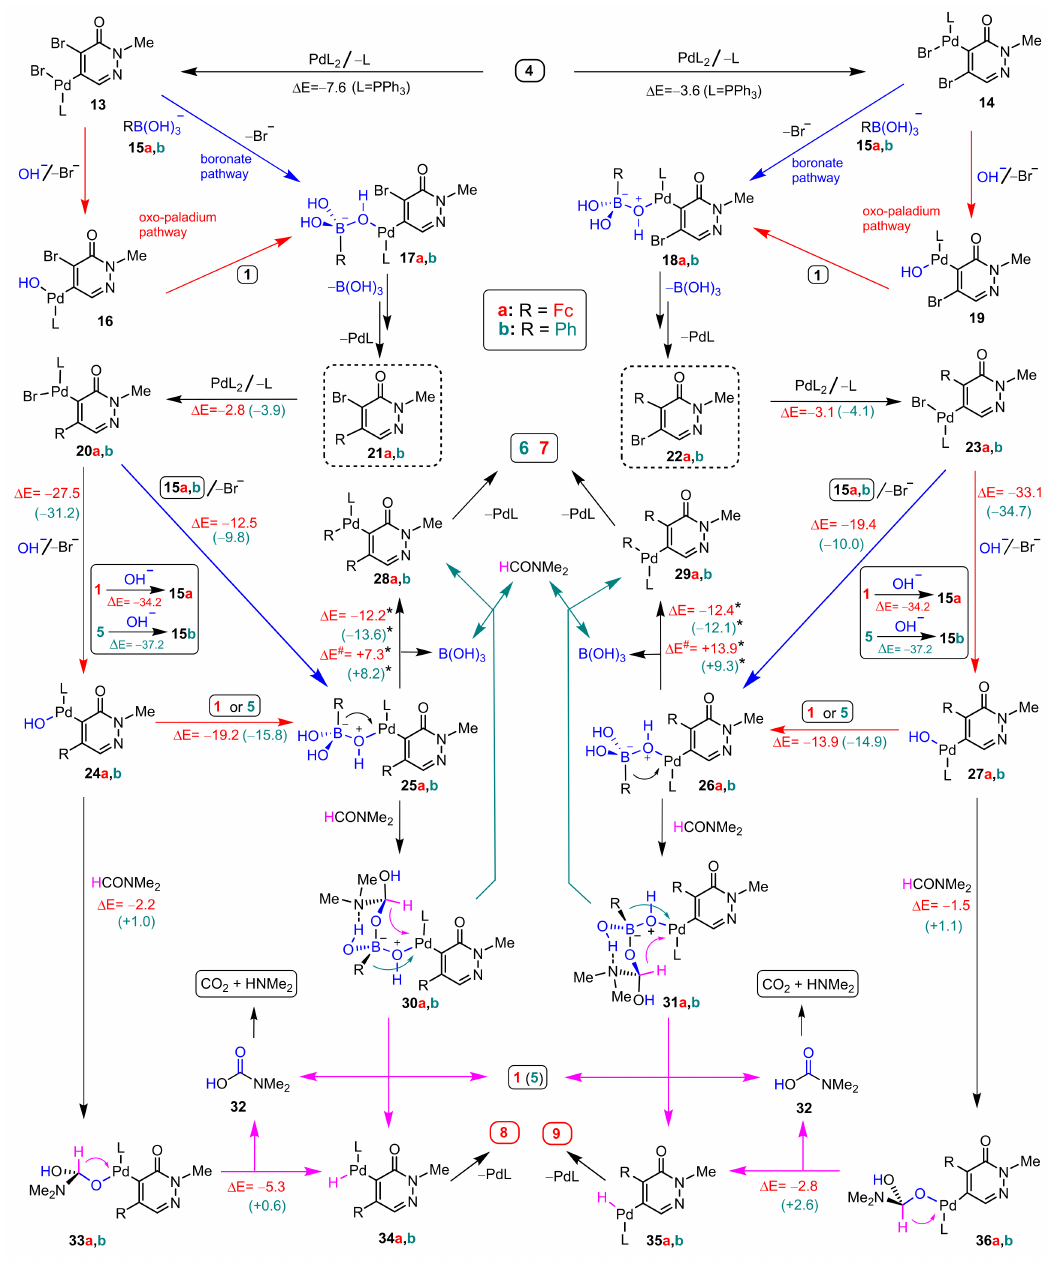
Scheme 2. The chart of DFT-modeled possible pathways without single electron transfer steps for sequential SM coupling reactions of 4 with 1 and 5 , respectively, aimed at disclosing the specific role of ferrocene moiety in the formation of 8 and 9 , under the conditions using Pd-catalysts with L = PPh 3 ligand and DMF–H 2 O (4:1) as solvent. [The values of relative energetics ( ∆ E) and activation barriers ( ∆ E # ) (in kcal/mol) calculated for the analyzed elementary steps involving ferrocene- and phenyl-containing components are presented in red and (green),